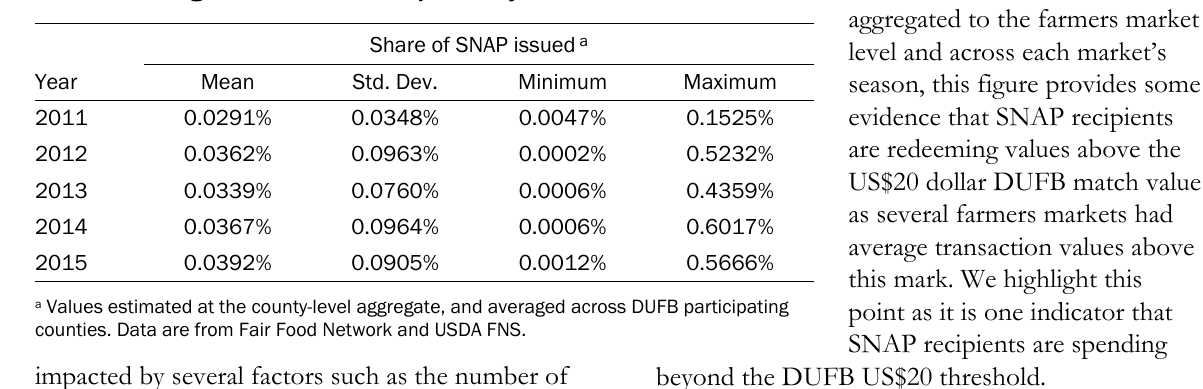
Table. 1 Average Share of SNAP Captured by Farmers Markets